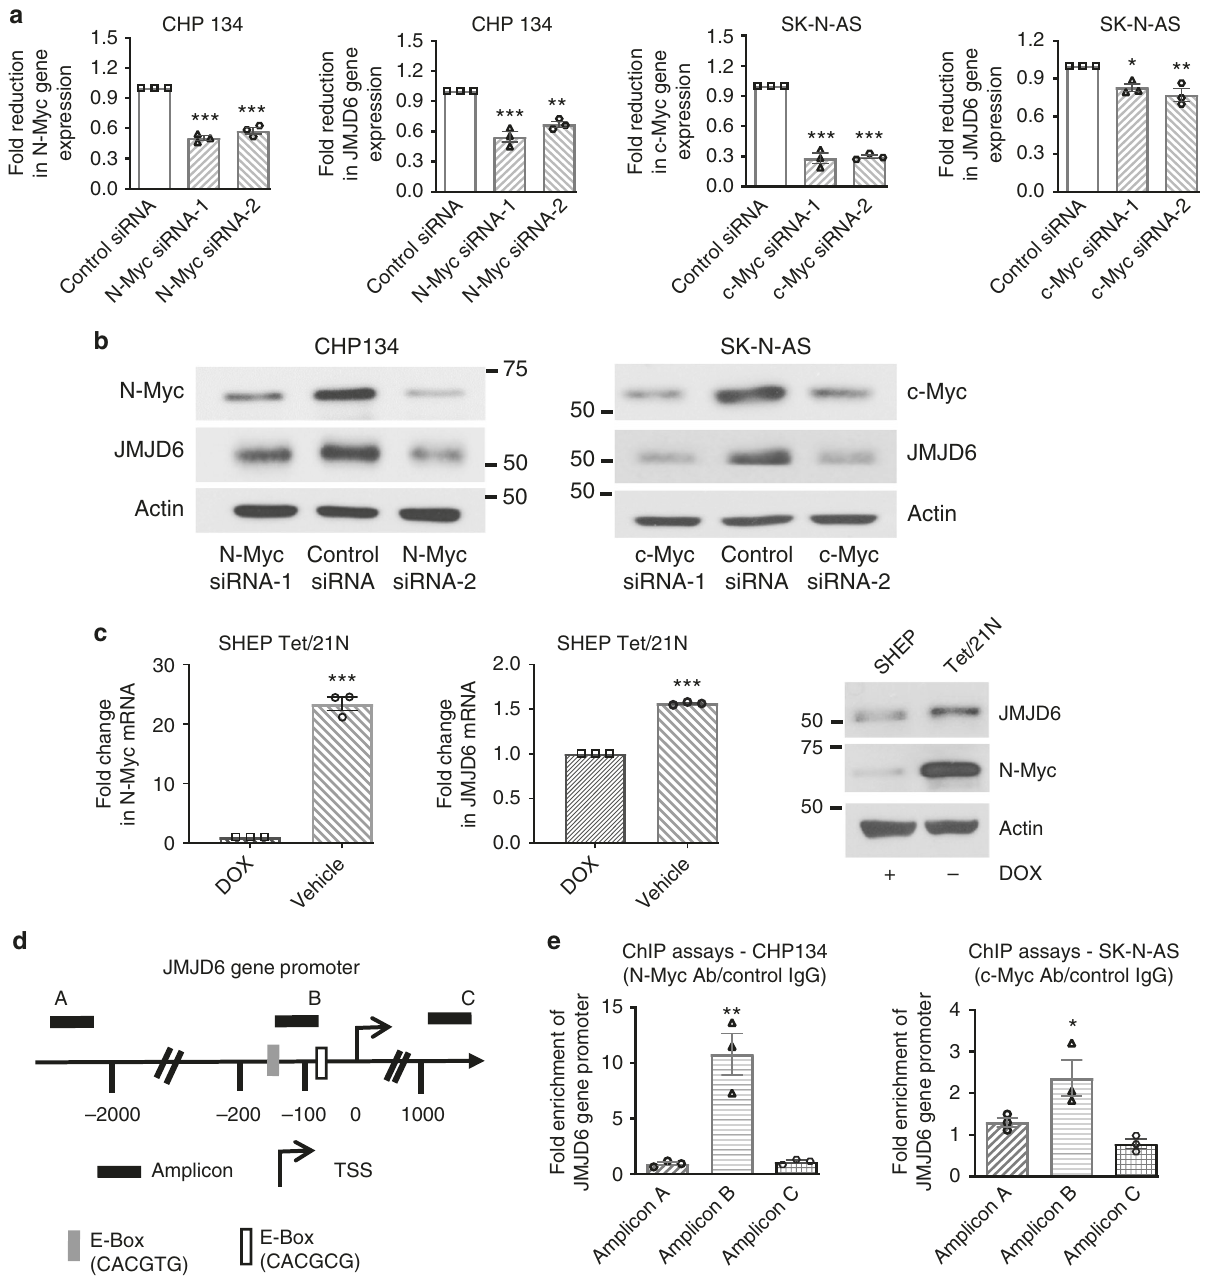
mentary Tables 1, 2).